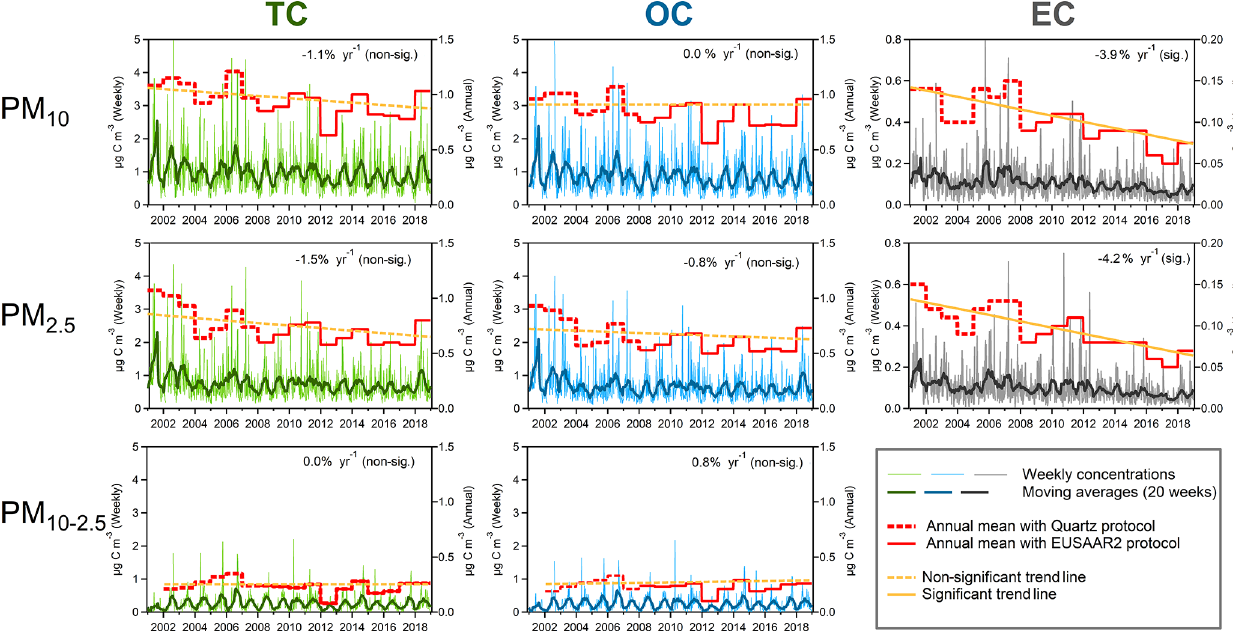
Figure 4. Ambient aerosol concentrations of TC, OC, and EC in PM 10 (upper panels); TC, OC, and EC in PM 2 . 5 (middle panels); and TC and OC in PM 10–2 . 5 (lower panels), presented as weekly (168h) and annual mean concentrations for the Birkenes Observatory for the 2001–2018 period. The trend lines account for the protocol shift.